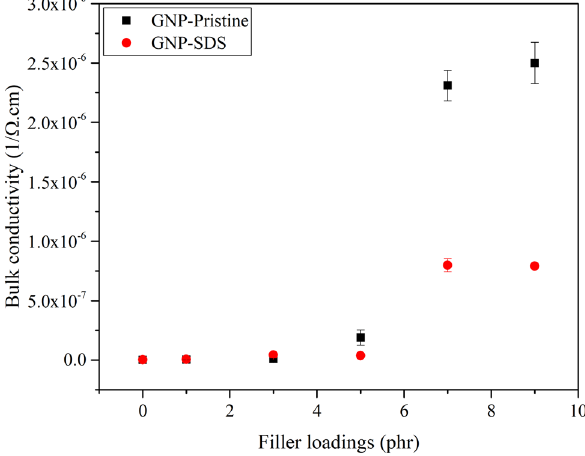
Figure 9: Bulk conductivity of NRL/GNP - pristine and NRL/GNP – SDS with various